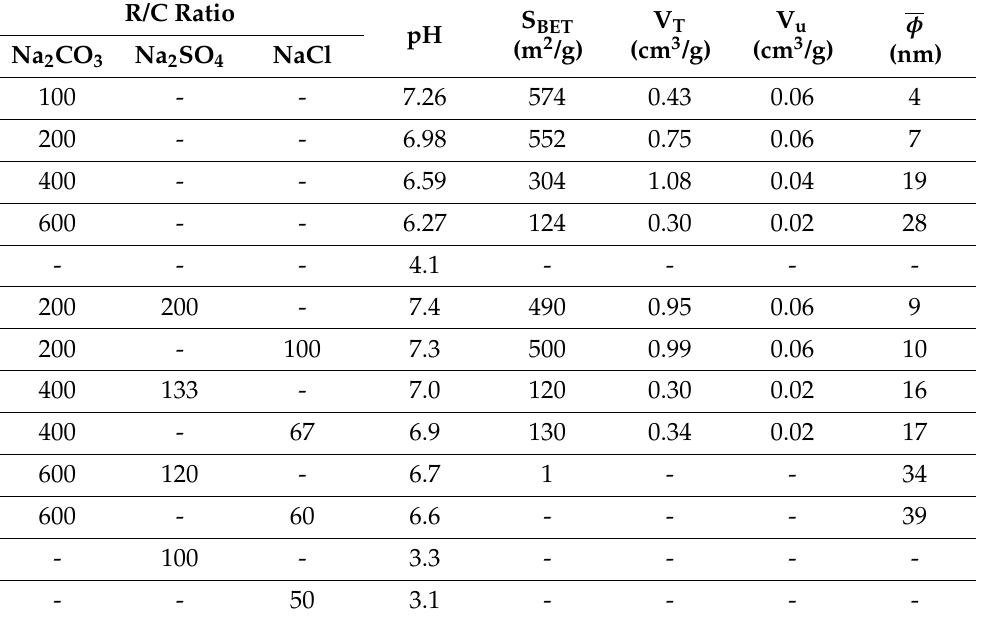
Figure 10. Nitrogen sorption isotherms of gels with modified catalyst composition ( a ) and corresponding pore size distributions ( b ). Note that INF represents infinite resorcinol/catalyst molar ratio (R/C ratio); therefore, zero concentration. Table 3. pH values of initial solutions and textural properties for gels with different resorci- and sodium chloride (NaCl). Note that S BET is Brunauer-Emmet-Teller (BET) surface area, V T is total pore volume, V u is micropore volume, and φ is average pore